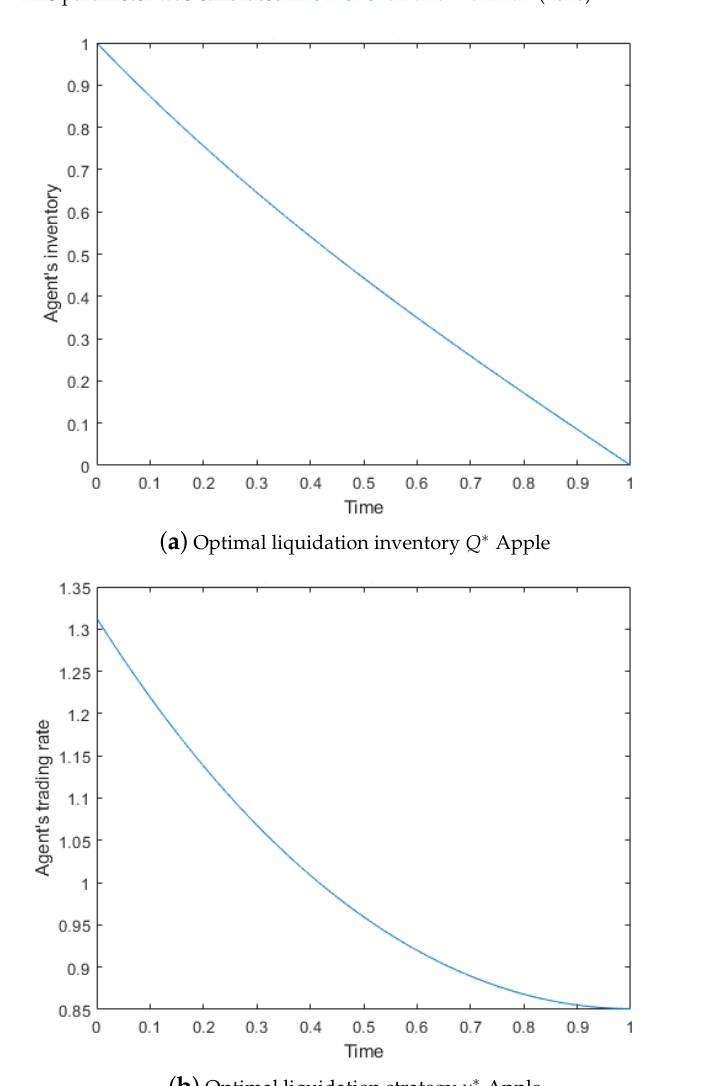
Figure 2. Optimal liquidation inventory and optimal liquidation strategy for Apple stocks. ( a ) the inventory calculated with Equation (33), using the parameters in Table 2. ( b ) the optimal liquidation value calculated with Equation (34), using the parameters in Table